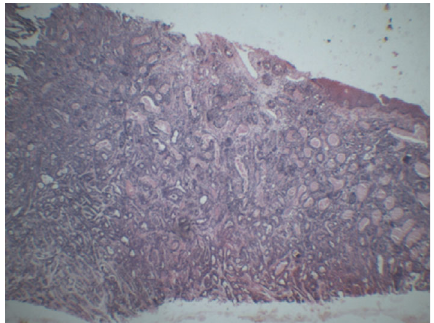
Figure 12: H and E section of tissue sample showing unencapsulated tumor close to surface epithelium with tumor cells arranged in solid nests.